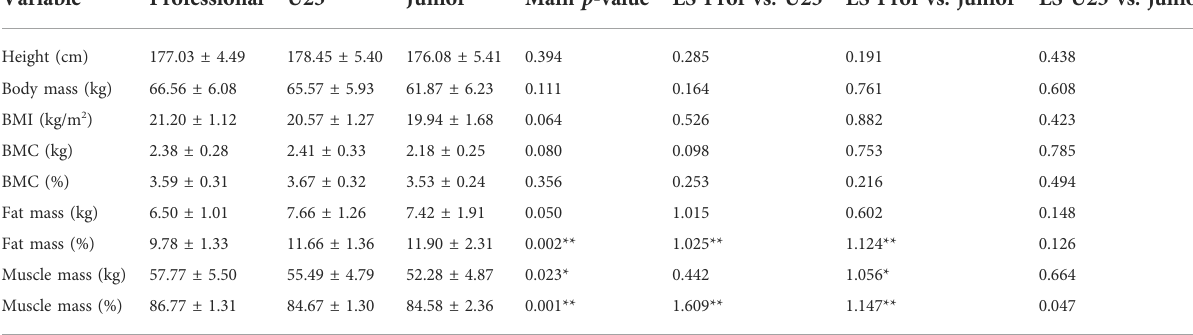
TABLE 3 Differences in body composition indicators between groups.